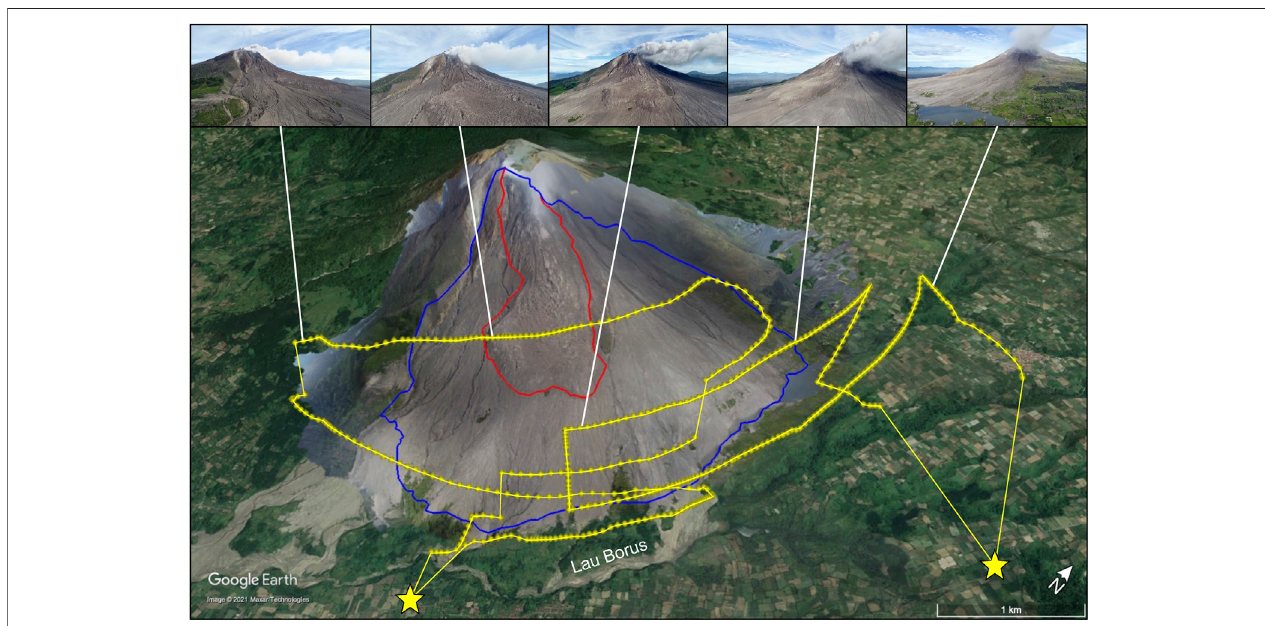
FIGURE 3 | UAS fl ights at Sinabung. We collected oblique images (insets) of Sinabung at different elevations and perspectives using a UAS. Two fl ights (yellow lines)wereneededtocompletethefullperspectiveofthe fl anksofSinabungaffectedbytheeruption.Takeofflocationsaremarkedbystars;yellowdotsarethelocations where the UAS captured images. Lines from the inset photographs to an image location indicate where the images were taken. The orthophoto derived from these photos using Agisoft Metashape ™ is shown draped over satellite imagery and topography in GoogleEarth ™ . A small ash-rich plume extending to the northeast was present during the fl ights, which limited the detail and extent of the orthophoto in this direction. The lake visible in the far right inset image and the orthophoto was formed when PDC deposits dammed the Lau Borus river. The lava fl ow is outlined in red and the area used for the volume calculation is outlined in blue.